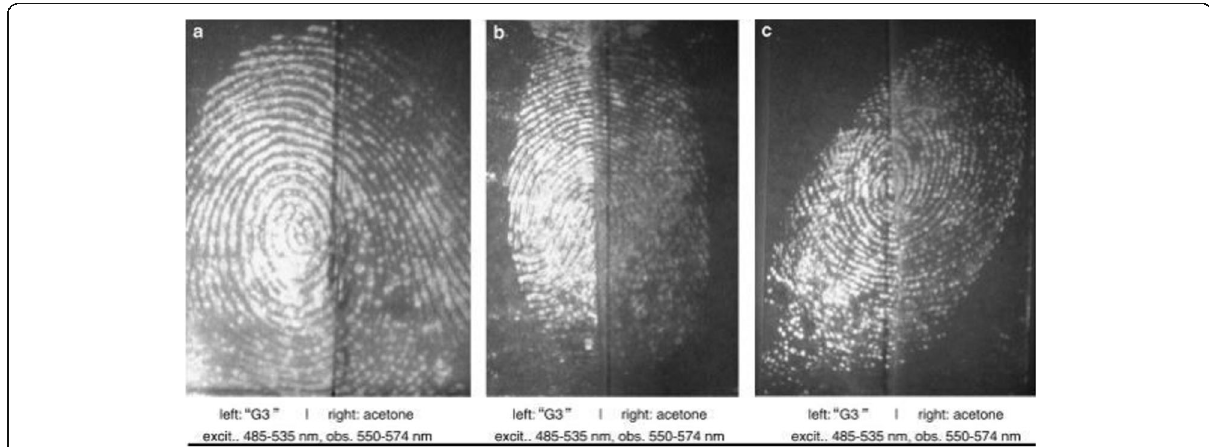
Fig. 6 Example of fingerprints on thermal paper developed using 1,8-diazafluoren-9-one (DFO) when compared with fingerprints developed with acetone ( a and b ) and ninhydrin treated prints ( c ) (adapted from Schwarz